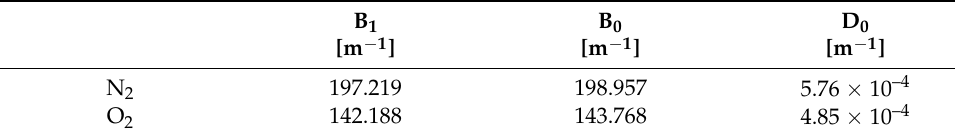
Table A2. Ground-state rotational and centrifugal distortion